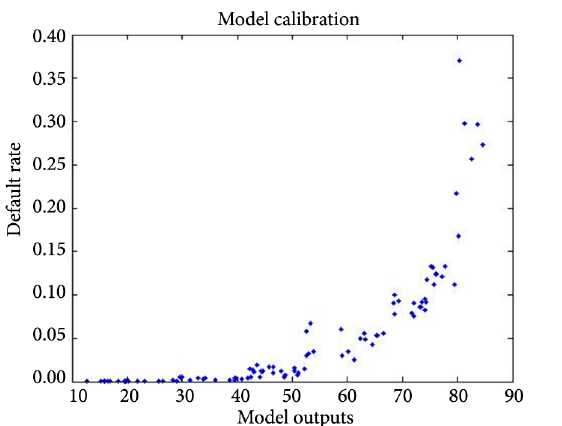
Figure 3. Model calibration mapping curve (source: own